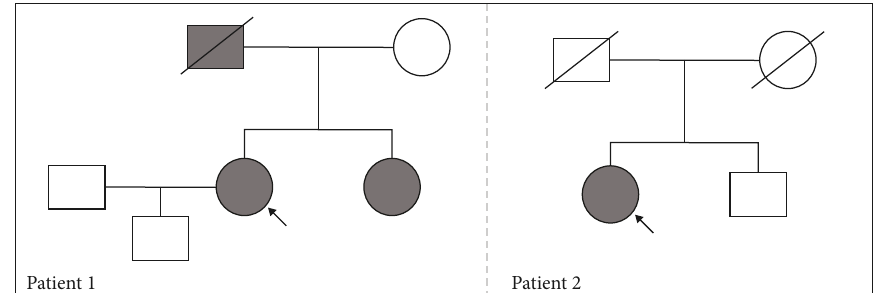
Figure 2: Pedigrees. Te proband is indicated with an arrow. Striped boxes represent males with Fabry disease; striped circles represent females with Fabry disease; slash indicates